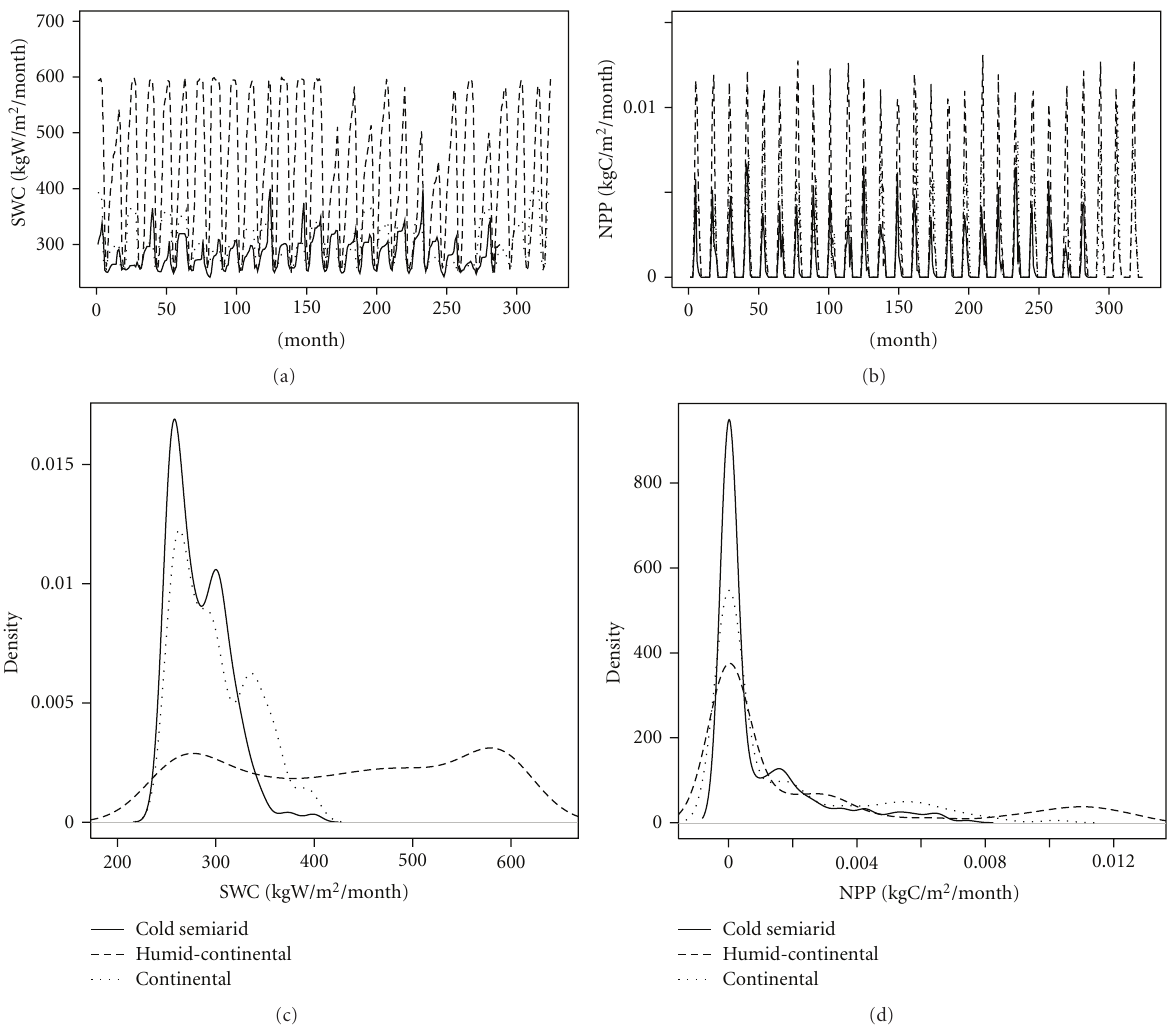
Figure 2: Monthly-average time series for: (a) SWC and (b) NPP and associated kernel density distributions for monthly averages of: (c) SWC; (d) NPP based on 1980–2006 records for humid-continental and continental, and 1980–2003 for cold semiarid climate agricultural